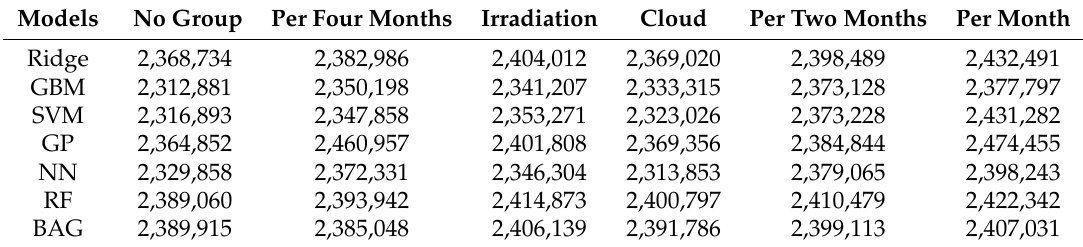
Table 3. The performances of various data classification methods are measured by the MAE in Wh/m 2 .